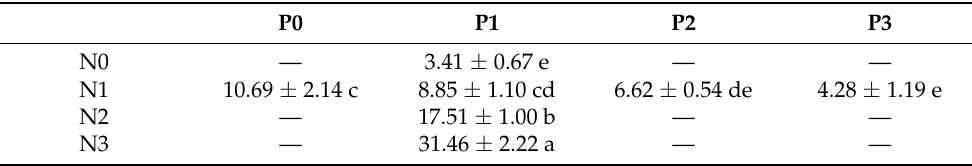
The values represent the mean of three replicates. Different letters indicate a significant difference at p <